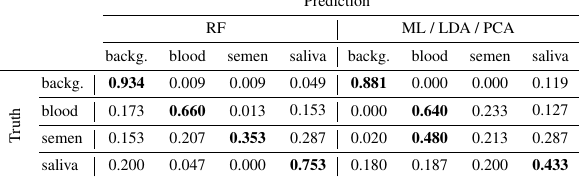
Table 3: Confusion matrix with classwise accuracies for multi- class